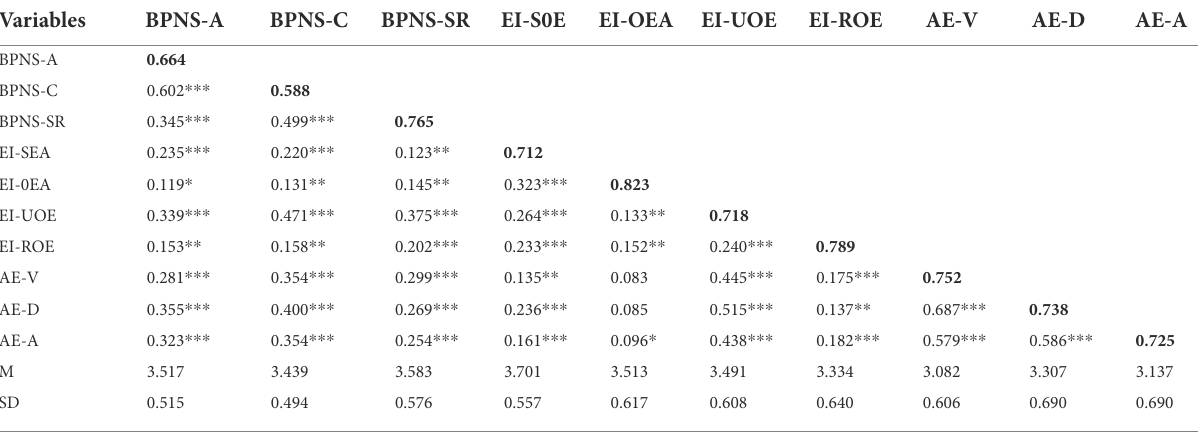
TABLE 2 Discriminant validity of the research instruments.